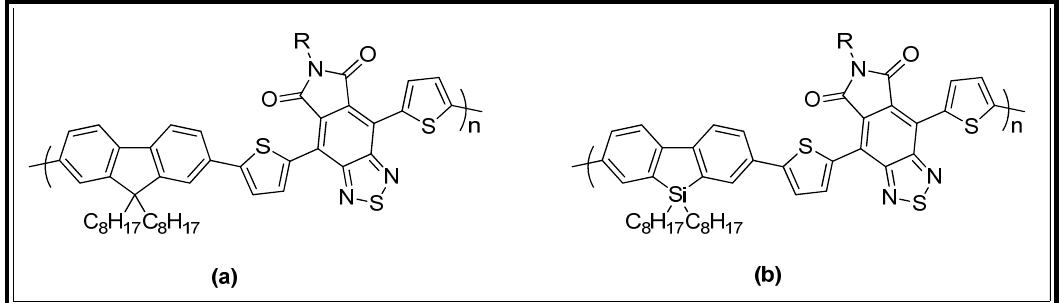
Figure 20. Molecular structures of: ( a ) P Si-FDTBT; ( b ) PFDT2BT.